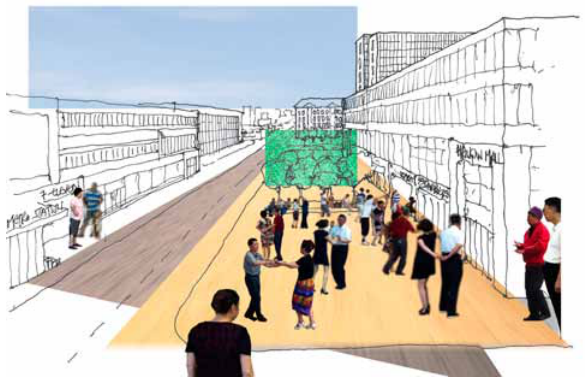
fig. 4. a collage of images forming a visual characteristics of community usage of public space in Putuo, embracing the sustenance local identity and create new place identity in new place making Note: Based on the different design approaches of public, parochial, and private space in new place making of Putuo